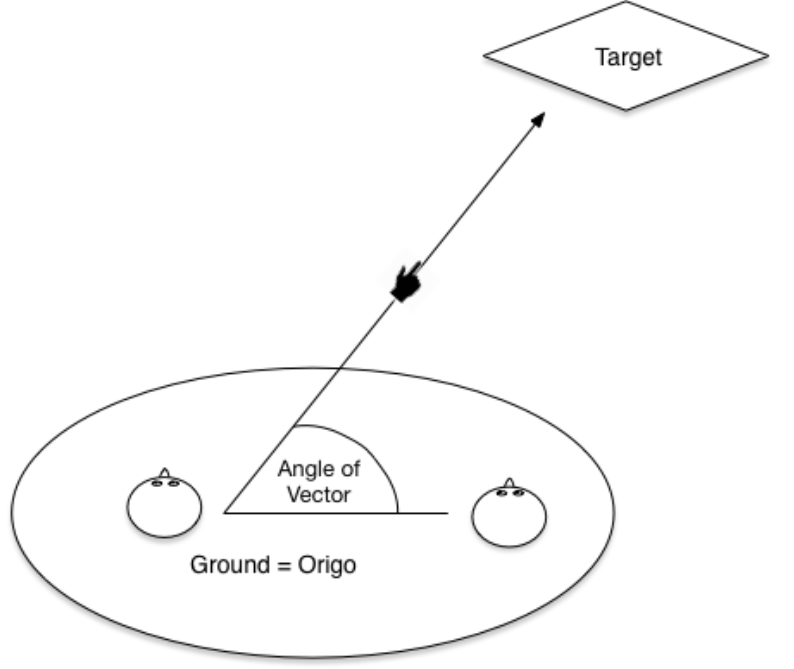
Figure 4: In pointing the angle of the indicated vector is interpreted relative to the physical orientation of the interlocutors. 4 Thakuny and batbat are unattested in Blythe’s corpus of transcribed Murrinhpatha conversation (4 hours and 48 minutes, to